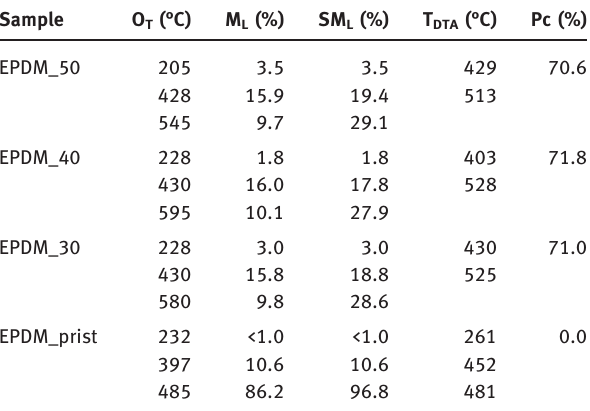
Table 4: Parameters of thermal decomposition of samples studied: onset temperature of changes in kinetics of decomposition (O T ), partial mass loss (M L ), summary mass loss (SM L ), temperature of maximal DTA peaks (T DTA ) and amount of residue in 1,000°C (Pc).